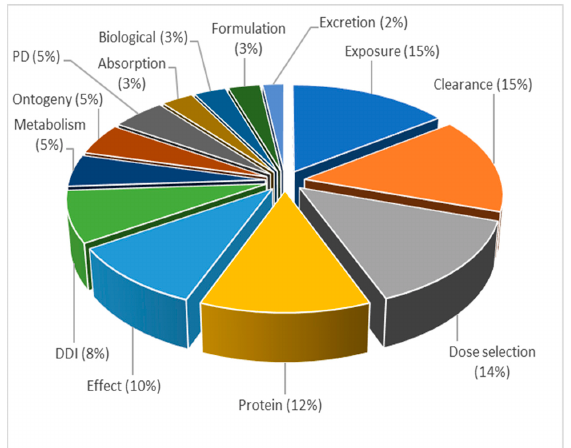
Figure 13. Distribution of published P-PBPK models per application area within topic 3, expressed as frequency (%), normalized to 100%.